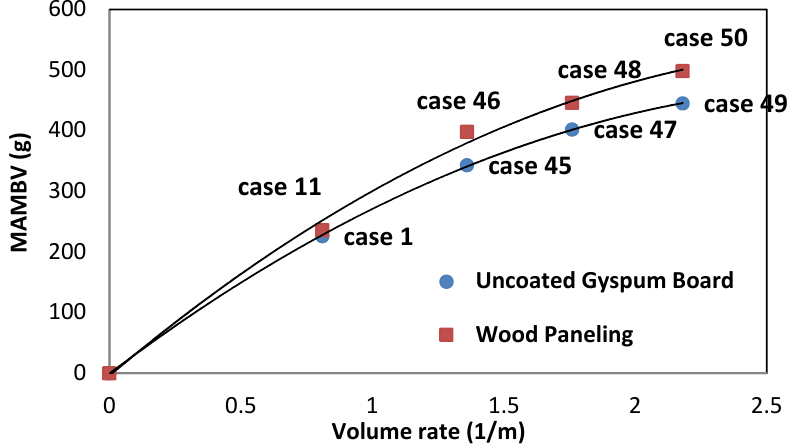
Figure 9. Maximum accumulated moisture buffering value as a function of volume rates for gypsum board and wood paneling under different volume rates.